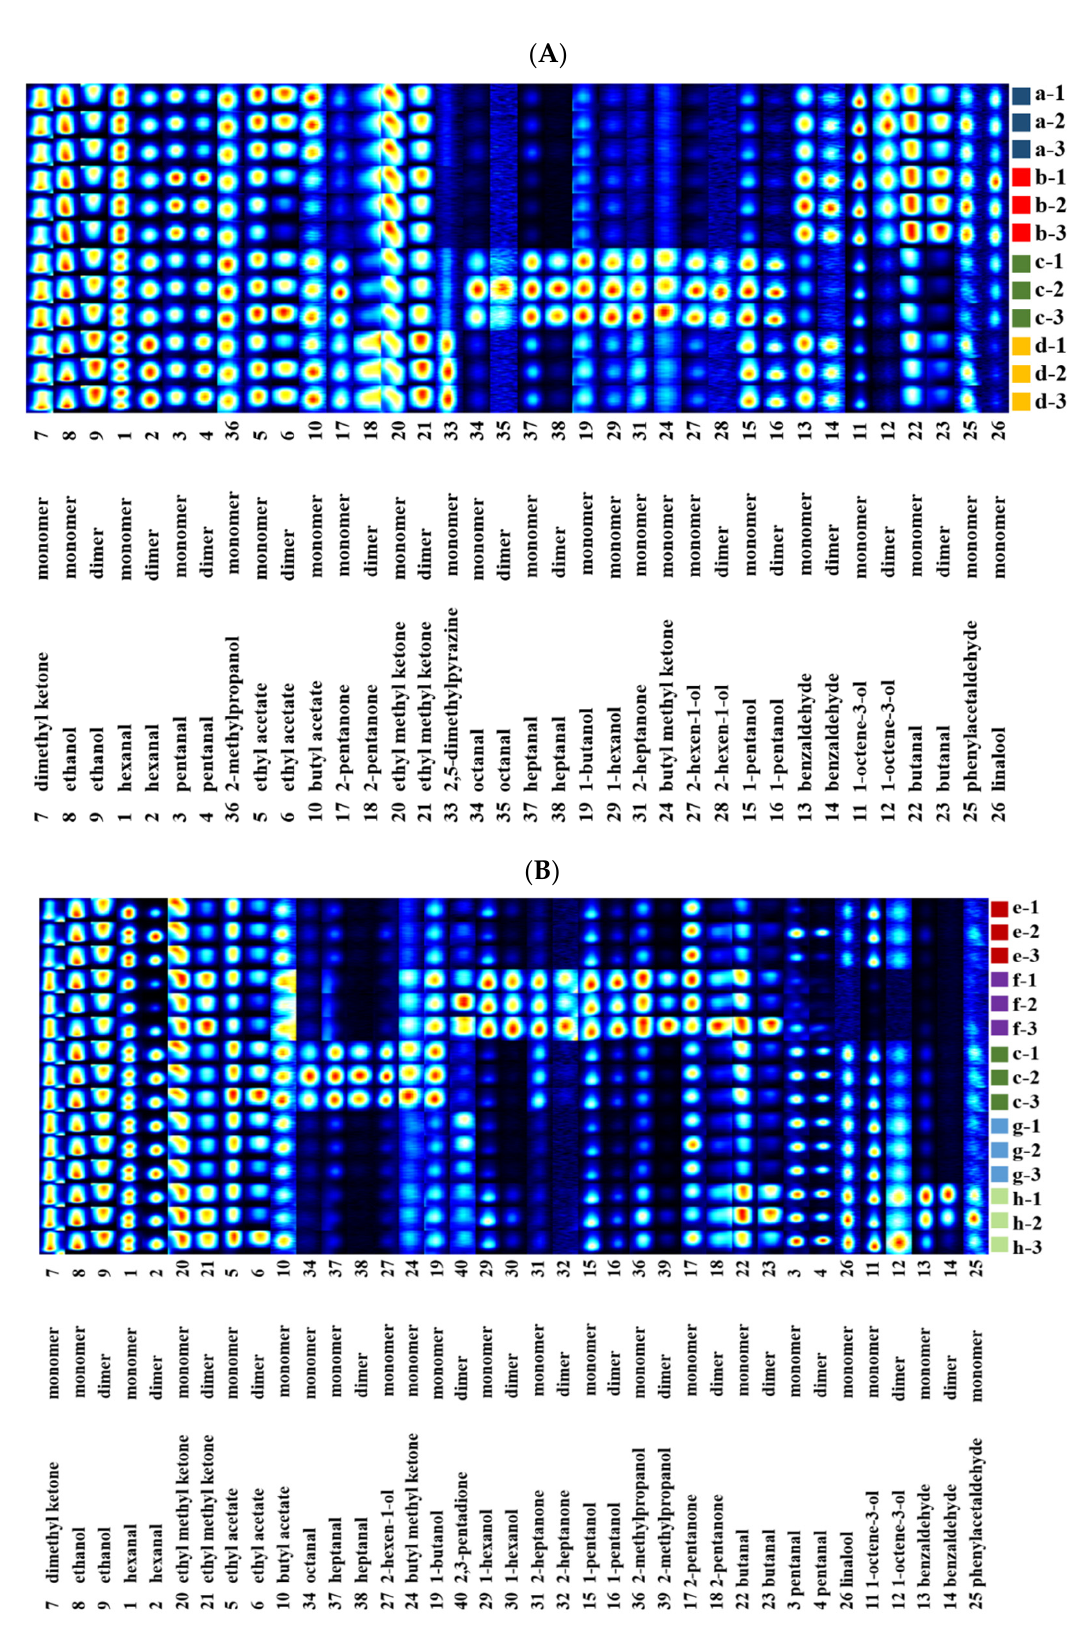
Figure 2. Gallery plot of the selected signal peak areas obtained from T. matsutake samples at different frying temperatures ( A ) and frying times ( B ): ( a ) 100 °C, 80 s; ( b ) 120 °C, 80 s; ( c ) 160 °C, 80 s; ( d ) 200 °C, 80 s; ( e ) 160 °C,40 s; ( f ) 160 °C, 60 s; ( g ) 160 °C, 100 s; and ( h ) 160 °C, 120 s.